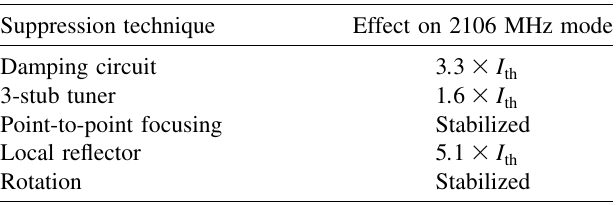
TABLE III. Summary of the BBU suppression techniques applied and their effect on the threshold current produced by the 2106 MHz